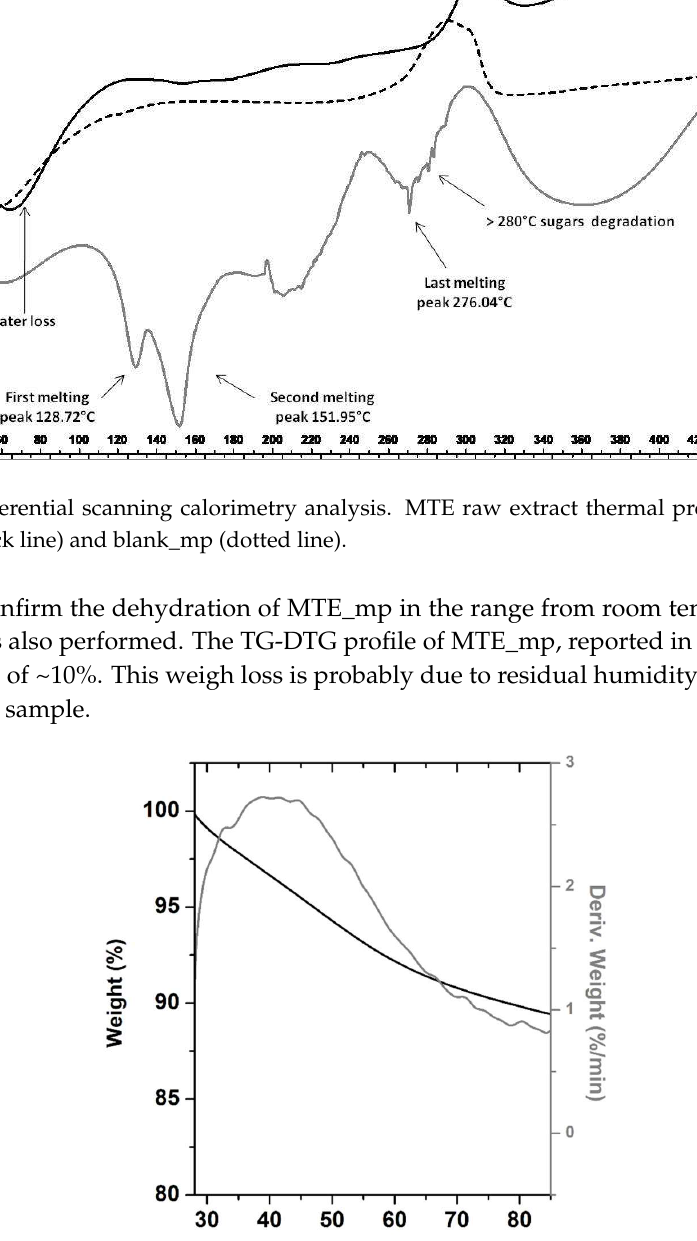
Figure 4. Thermogravimetric analysis. TG-DTG (black line and gray line, respectively) profile of MTE_mp.